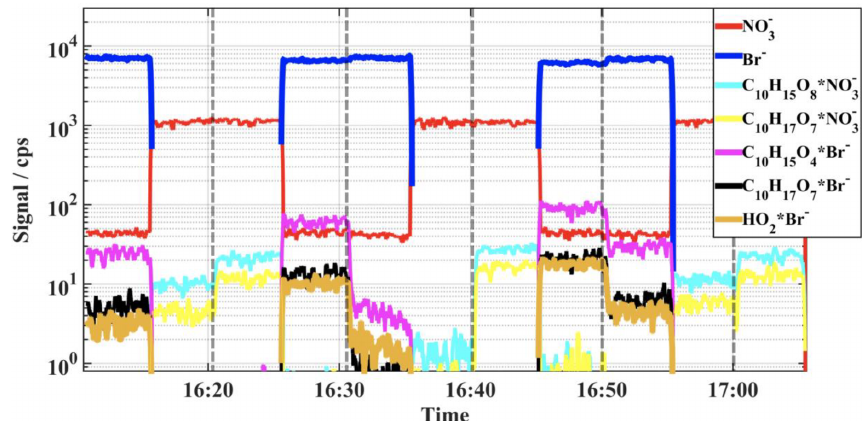
Figure 5. Time traces measured for the reagent ions and selected α -pinene oxidation derived peroxy radicals illustrating the fast switching between reagent ion modes; the highly oxidized RO 2 (C 10 H 17 O 7 ) is retrieved well by both ion modes, whereas, the primary peroxy radicals HO 2 and C 10 H 15 O 4 were detected only with Br − ionization. The changes in the product signal levels are due to different hydrocarbon loads in the flow reactor, and the changes have been marked with vertical dashed lines. At the highest concentration experiments (at around 16:45; α -pinene about 500ppb), small but measurable signals were retrieved also for the nitrate ion clustered